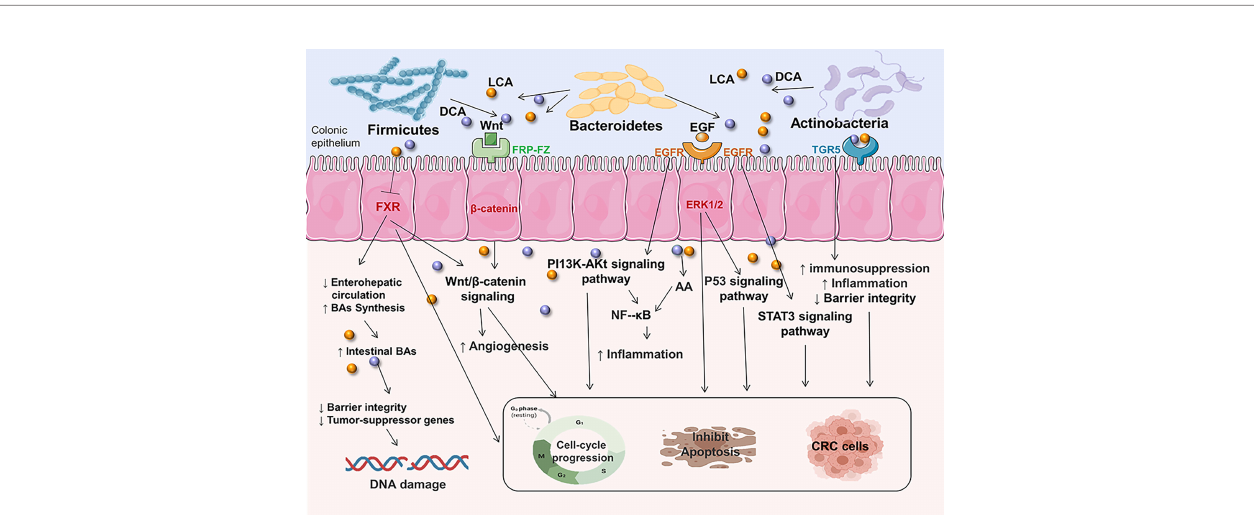
FIGURE 2 | Secondary BAs promote CRC initiation and progression by inducing CRC-associated signaling. DCA and LCA are major secondary bile acids produced by gut bacteria through cholic acid metabolism, which can bind to host receptors, including nuclear hormone receptor FXR and G-protein-coupled receptor 1 (TGR5). This can increase the risk of CRC by triggering multiple cellular signals and genotoxicity, disrupting epithelial barrier integrity, driving in fl ammation immunological dysfunction. Multiple signaling pathways are involved in complex disease process. EGFR, epidermal growth factor receptor; FXR, farnesoid X receptor; Wnt, wingless-related integration site; ERK1/2, extracellular signal-regulated kinase 1/2; AA, arachidonic acid; PI3K/AKT, phosphatidylinositol-4,5-bisphosphate 3-kinase/serine-threonine kinase; EGF, epidermal growth factor; STAT3, signal transducer and activator of transcription